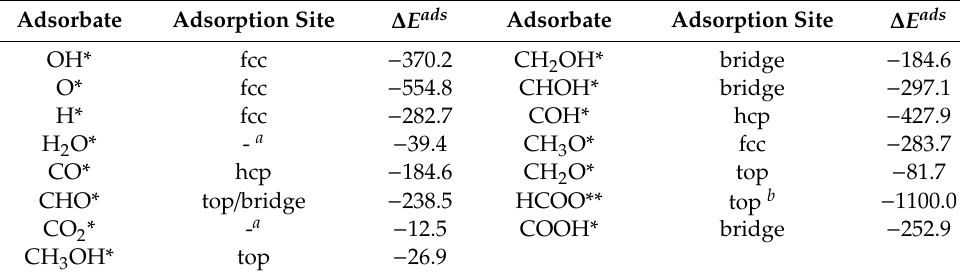
Table 1. The most stable adsorption site and adsorption energy (kJ / mol) of adsorbate on